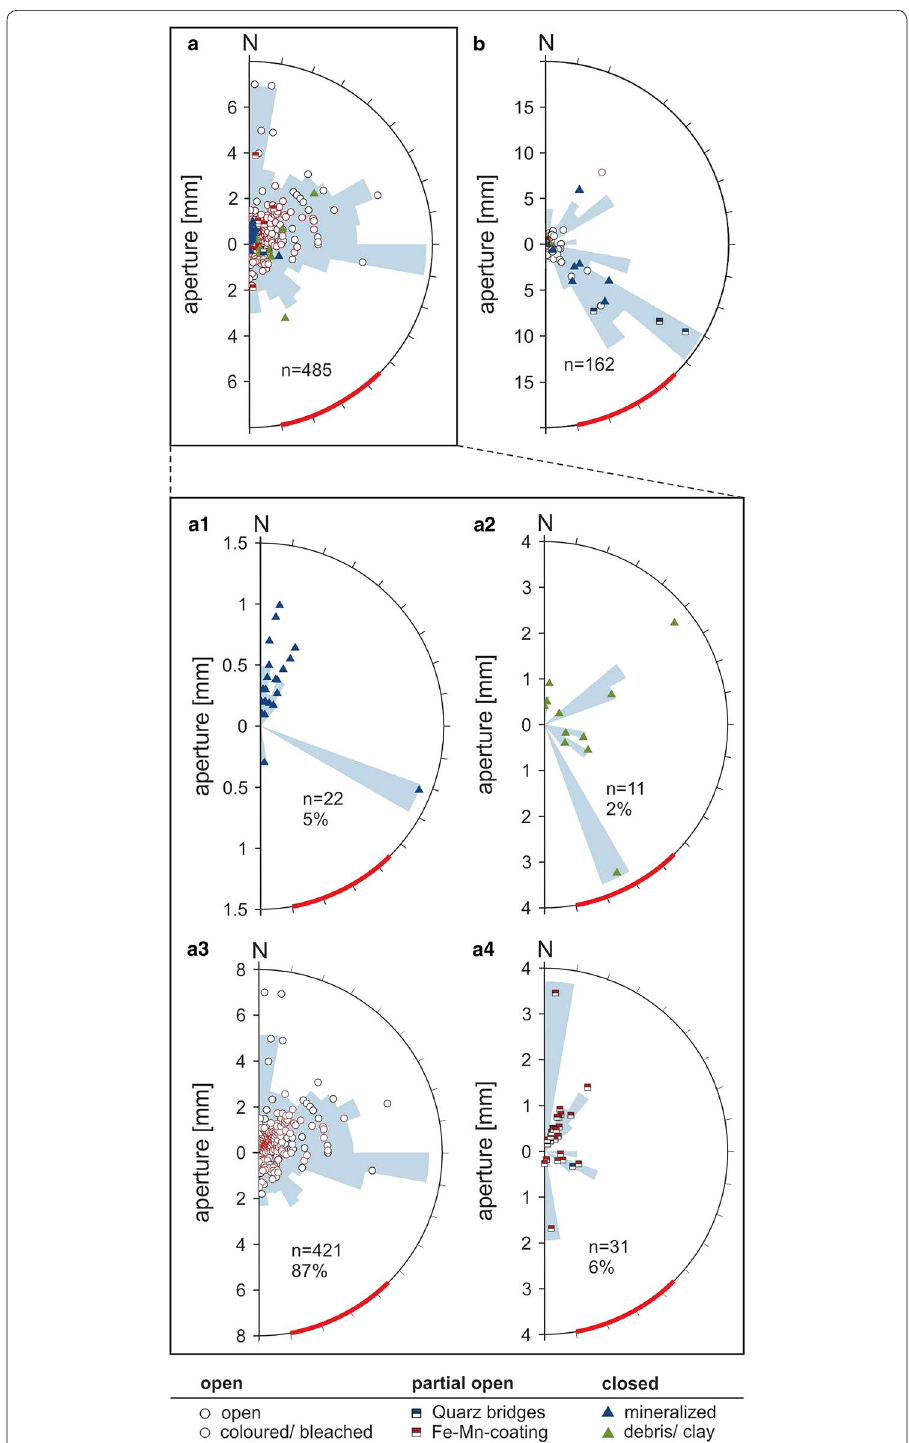
Fig. 8 Half‑circular diagrams showing the relation between fracture strike and apertures or thickness of fill, respectively. a Cleebourg, (a1–a4) fracture data from the Cleebourg outcrop with adjusted scale for improved readability and b Leistadt. Apertures from the eastern outcrops of Kammerforster and Riesenstein are not available. Rose diagrams scaled for mean aperture in 10° bins. The bold red lines show the direction of the regional maximum horizontal compressive stress (NW–SE to NNW–SSE; Heidbach et al.